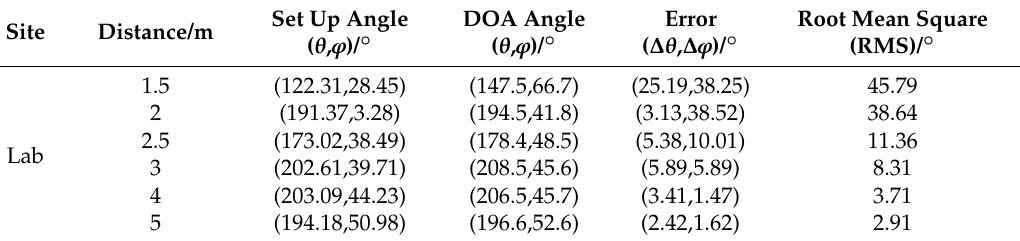
Table 3. Test results in lab.